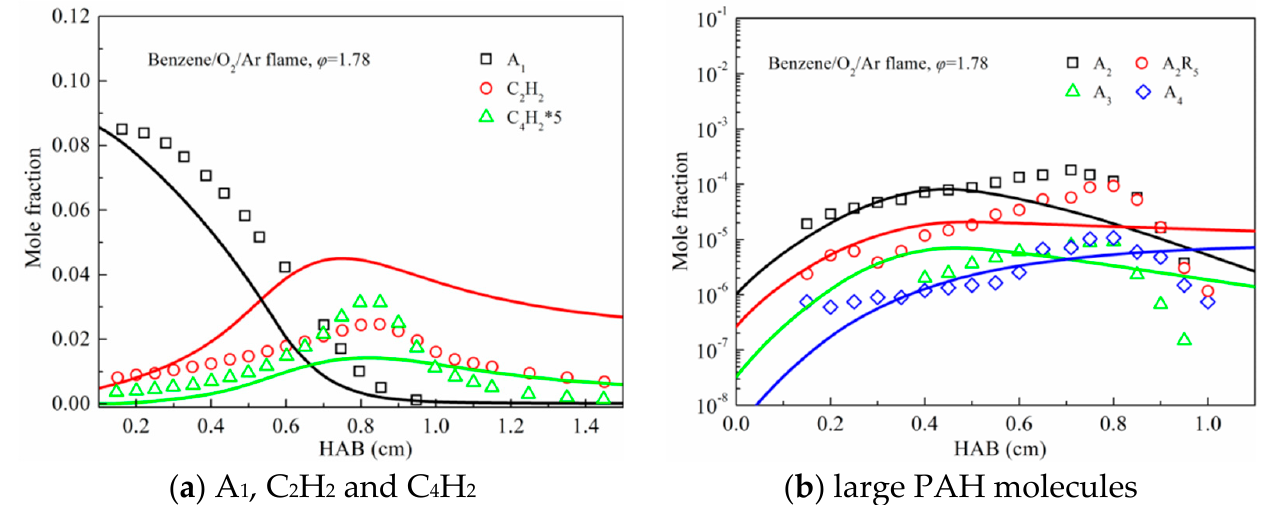
Figure 11. Measured [49] (symbols) and predicted (lines) species profiles in the premixed benzene flame with ϕ = 1.78.